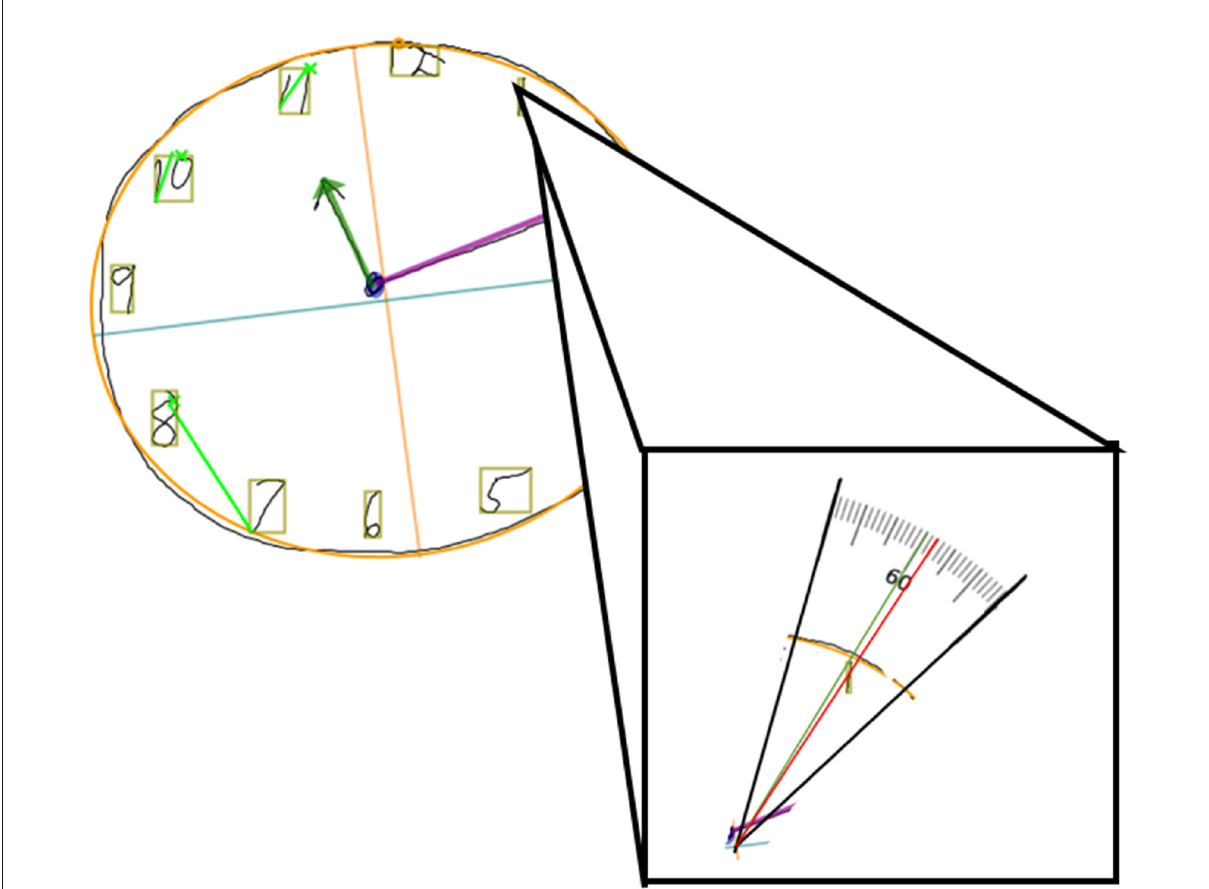
FIGURE1 Example of a digital clock drawing, with the clock face of best-fit outlined in orange, the center point indicated by the orange and blue crosshairs, and the digit bounding boxes in tan. Close up of digit 1, which should be centered at 60 ◦ (green line) but is slightly misplaced (red line crossing through tan bonding boxes center) at 57.502 ◦ . The difference between the red and green values is how misplaced the digit is, indicated as “Digit 1 Ideal Difference”. In this case, Digit 1 Ideal Difference is 60 − 57.502 = 2.498 ◦